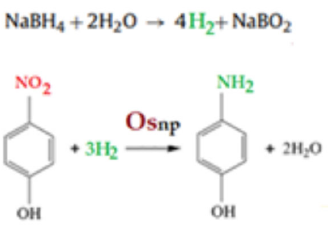
Figure 10. Reaction schematic for the catalytic reduction of p –nitrophenol ( p NP) to p –aminophenol (pAN) with molecular hydrogen. (pAN) with molecular